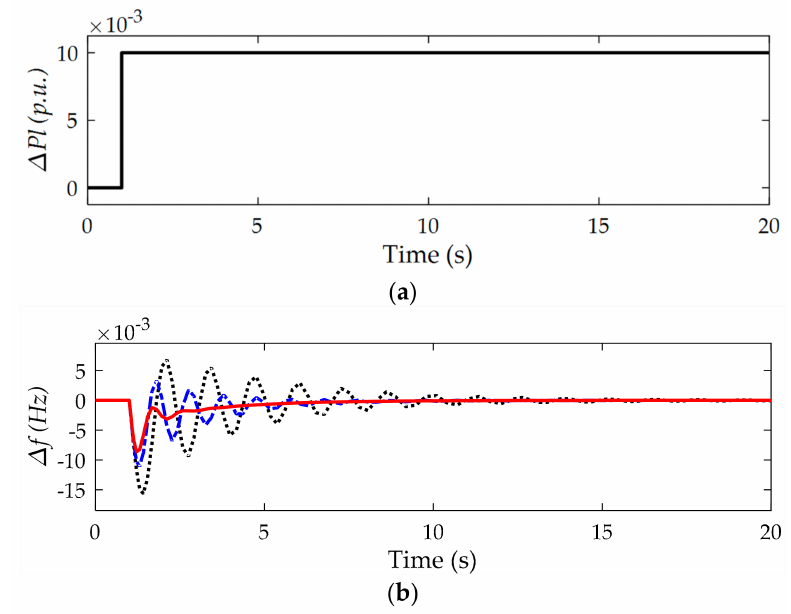
Figure 8. The power system frequency deviation disturbed by the step signal, without energy storage unit (black-dotted), with battery (blue-dashed), and with ultra-capacitor (red-solid), ( a ) the step signal; ( b ) the frequency